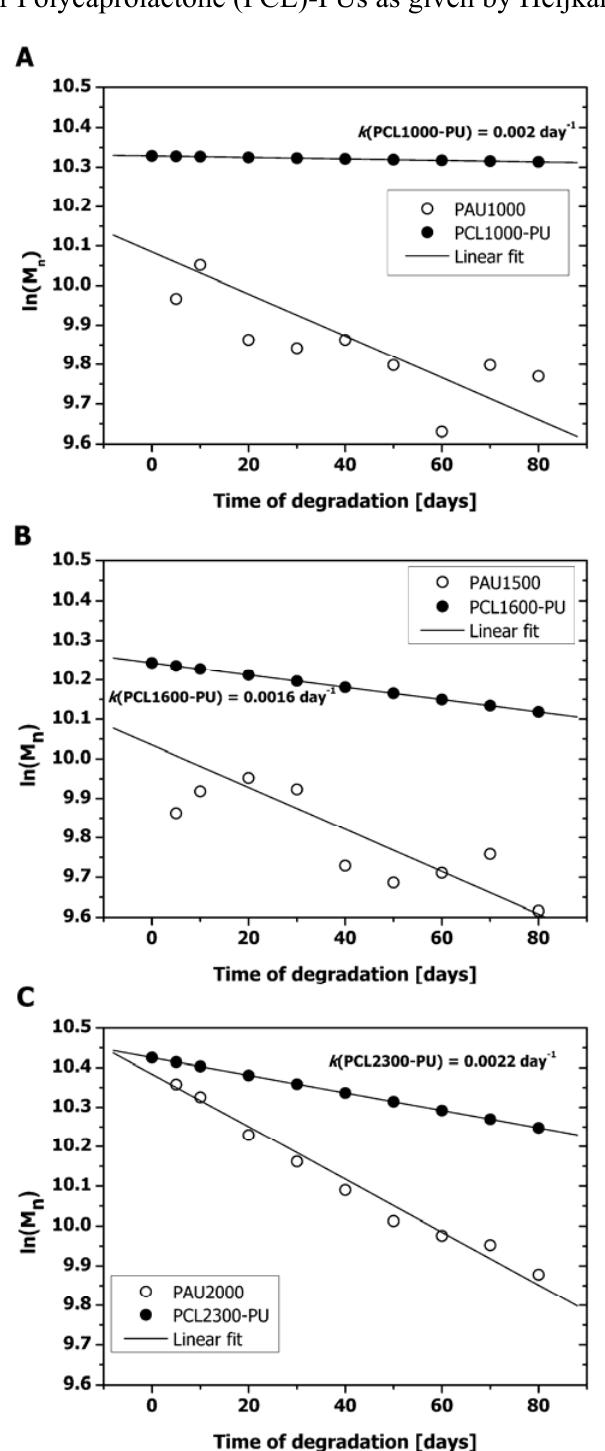
Figure 2. Decrease of PAUs’ molar mass in the course of hydrolytic degradation. ( a ) PAU1000 compared to PCL1000-PU; ( b ) PAU1500 compared to PCL1600-PU; ( c ) PAU2000 compared to PCL2300-PU. Data set for PCL-PUs was calculated